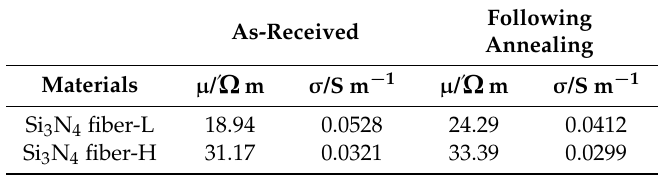
Table 4. Resistivity and conductivity of two fibers prior to and following